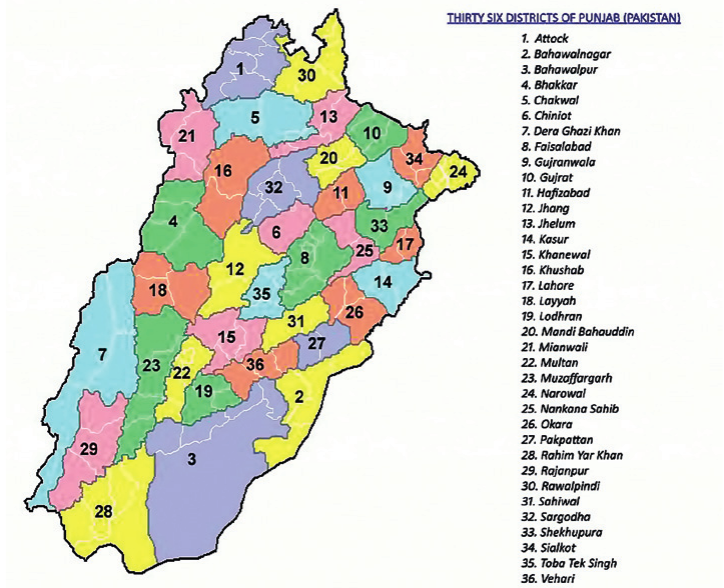
Fig. 1. Map of Punjab showing the 36 districts of the